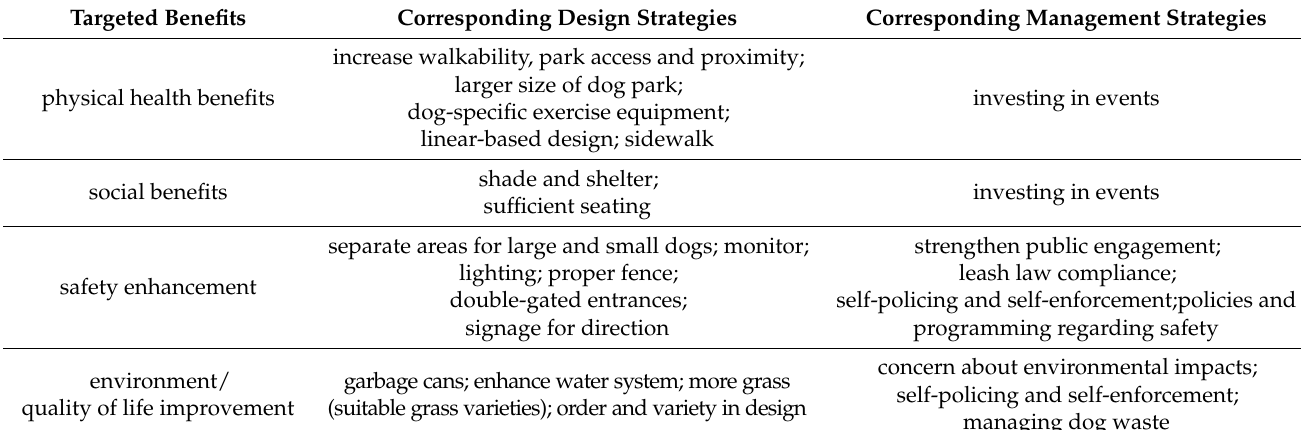
Table 2. Targeted benefits and their corresponding design and management strategies for dog parks.